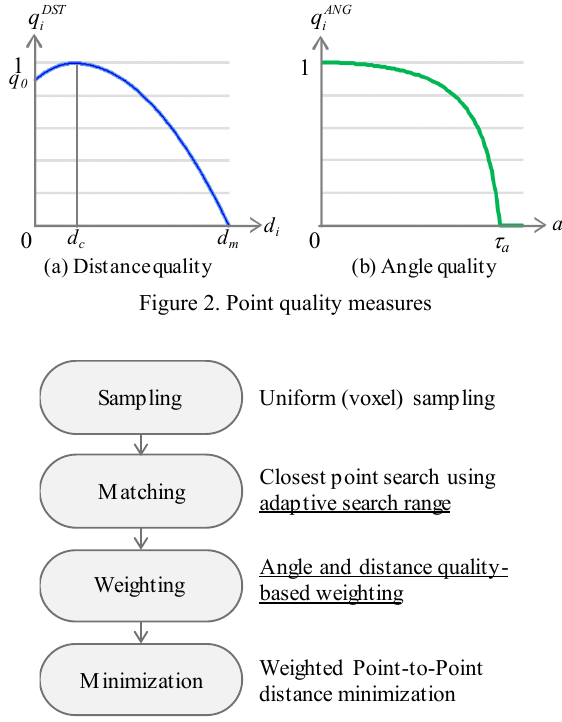
Figure 3. ICP Algorithm used in our